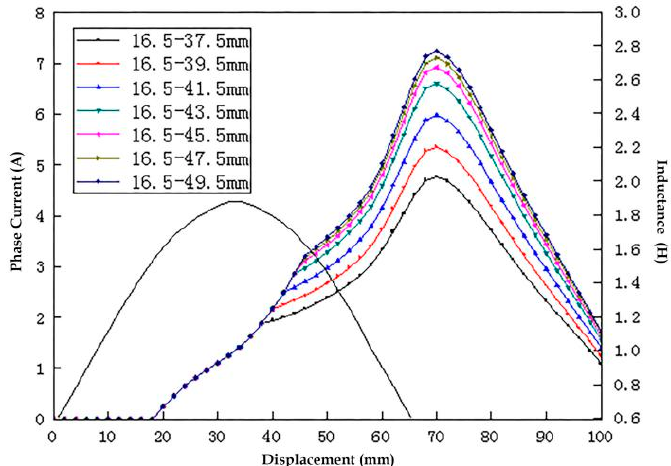
Figure 9. The turn-on position is 16.5 mm. The phase current waveform at different turn-off positions is shown in Figure 9, it can be seen from the Figure 9 that the turn-off position has a great influence on the current in the generation stage.